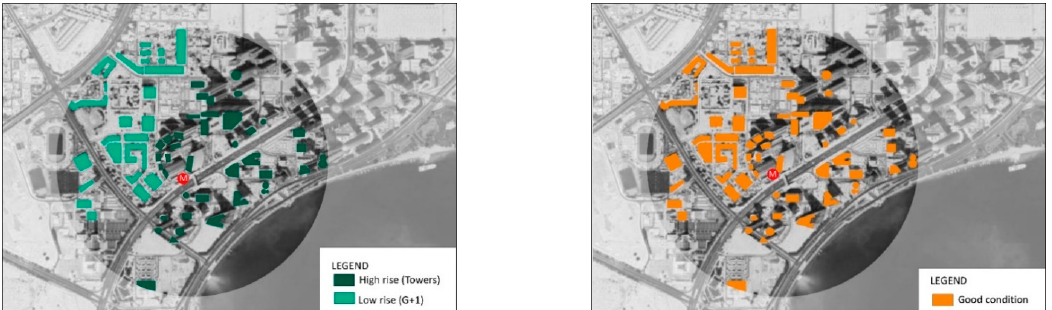
Figure 19. ( left ) map showing building density; ( right ) condition of buildings in the study area (Source: the Authors).